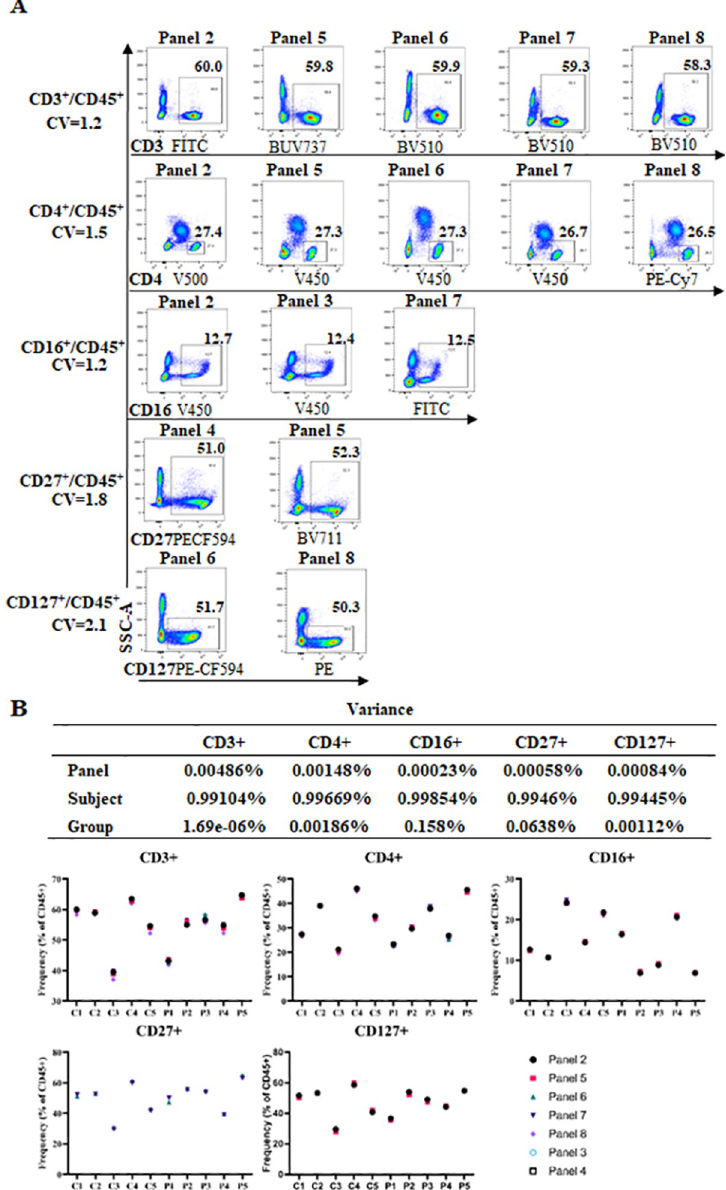
Fig 1. The selected immune cell populations were identifiable across panels. (A) CD3 vs SSC-A, CD4 vs SSC-A, CD16 vs SSC-A, CD27 vs SSC-A, and CD127 vs SSC-A plots (after gating on CD45+ but excluding granulocytes) from one healthy control across seven panels (panels 2–8) showed very similar population frequencies for each immune subset. Among these, CD3 with 2 clones (UCHT1, SK7) and three fluorochromes (FITC, V510-CD3, BUV737); CD4 with 3 fluorochromes (V450, V500, PE-Cy7) and one clone (RPA-T4); CD16 with 2 fluorochromes (V450, FITC) and two clones respectively (3G8, NKP15); CD27 with two fluorochromes (PE-CF594, BV711) and two clones respectively (M-T271, L128); CD127 with two fluorochromes (PE and PE-CF594) and one clone (HIL-7R-M21). The CVs of these populations are shown. (B) The variation in cell proportions explained by differences across panels (panel 2–8), subjects (n = 10), and groups (control, n = 5 and patient, n = 5) in the proportion frequencies of CD3+ and CD4+ (on panel 2, 5, 6, 7 and 8), CD16+ (on panel 2, 3 and 7), CD27+ (on panel 4 and 5), CD127+ (on panel 6 and 8) in total CD45+ cells for control samples 1–5 and patient samples 1–5 at pre-transplantation.